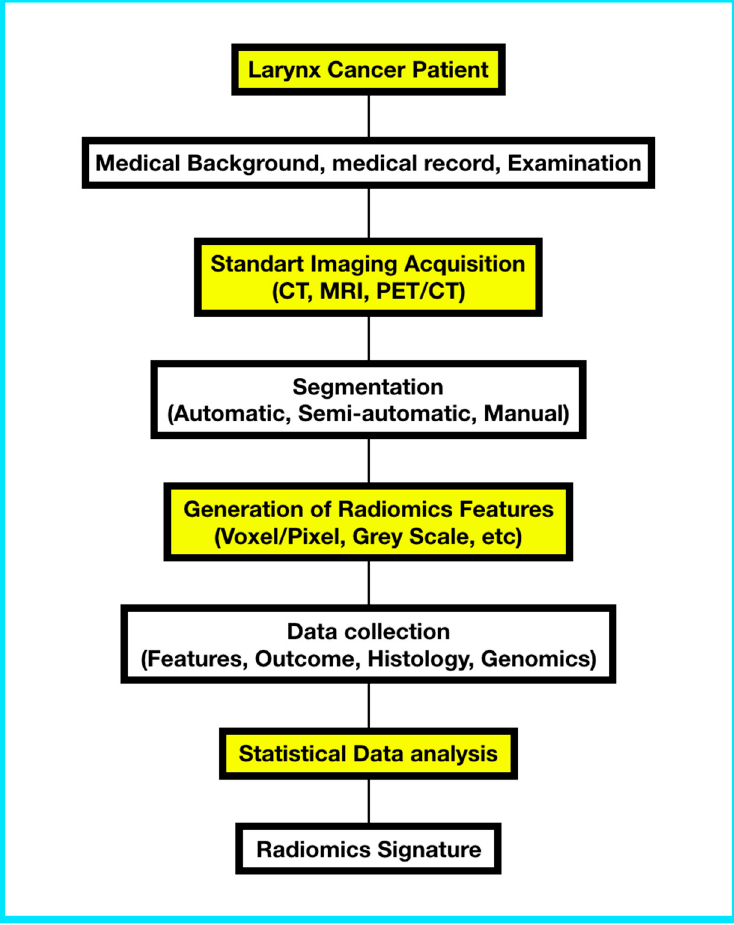
Figure 1. Workflow for creation of a radiomic signature in a larynx cancer patient.